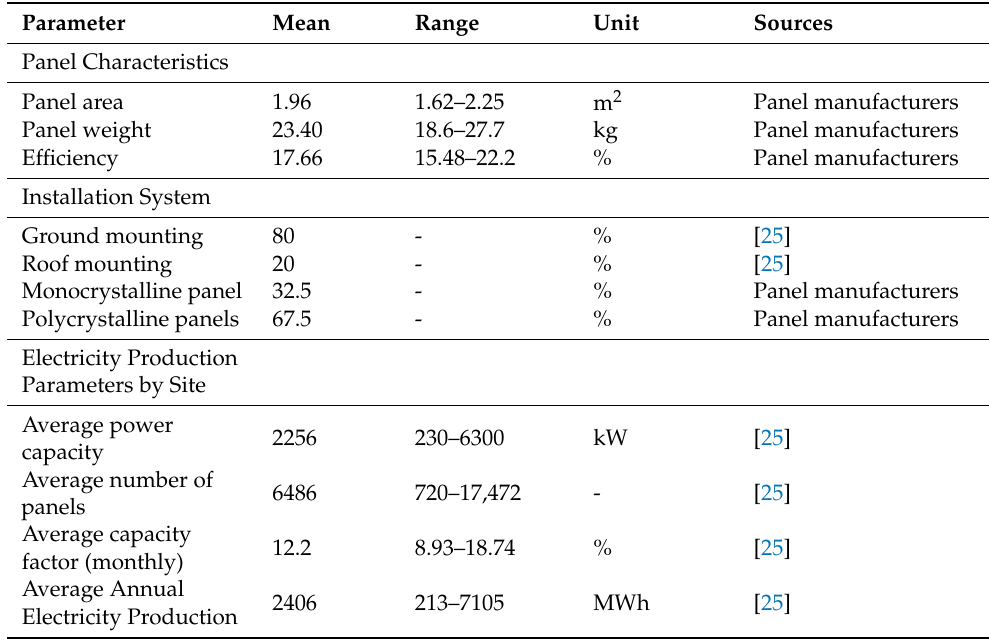
Figure 1. Location of the 120 solar photovoltaic sites in New York State, USA analyzed by this study [25]. Only sites with more than one year of available electricity output data were used. This comprehensive LCA includes all the steps of electricity production via distrib- Table 1. Summary of 120 solar PV systems’ characteristics, installation systems, and system parame- uted solar photovoltaics, from the extraction of raw materials to the PV panels’ EoL (Fig- ters that were used in LCA of solar systems in ure 2). Based on the panel manufacturers’ datasheets, it is assumed that the manufacturing